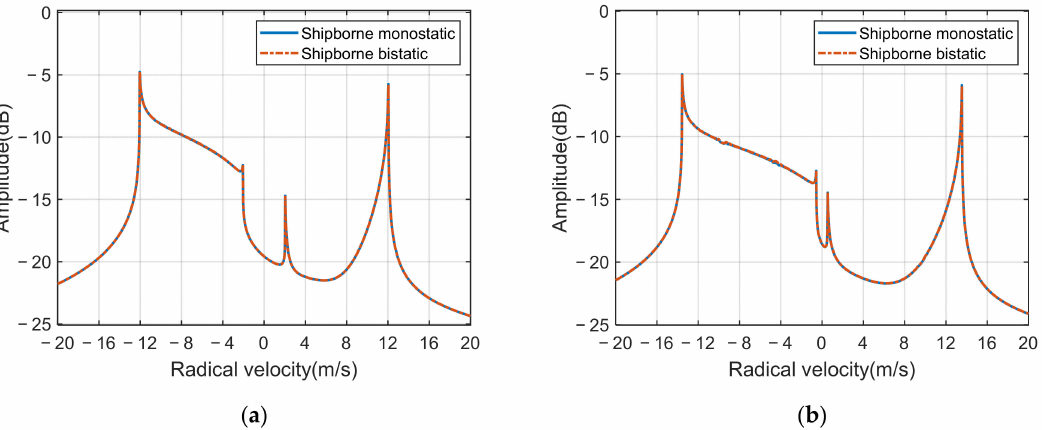
Figure 3. Simulated shipborne bistatic (red dotted line) and shipborne monostatic (blue solid line) first-order Doppler spectra for a detection range sum of 150 km. ( a ) The platforms’ speed is 5 m/s. ( b ) The platforms’ speed is 6.5